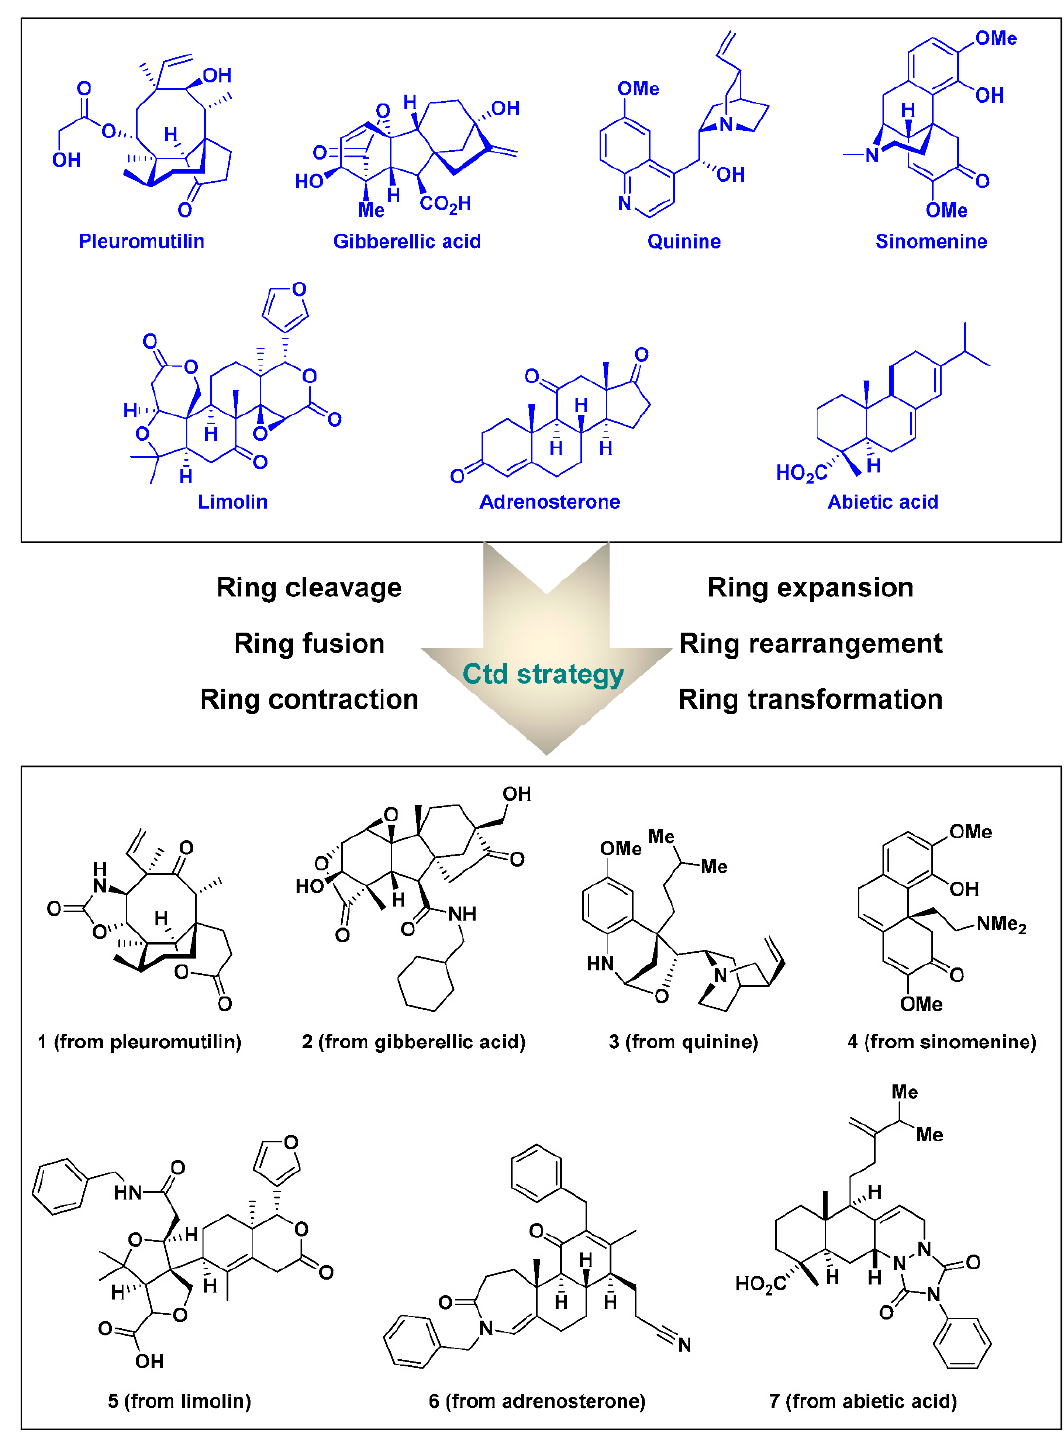
Figure 1. Natural products as starting points in the complexity-to-diversity (Ctd) strategy along with representative compounds generated via ring-distortion reactions.